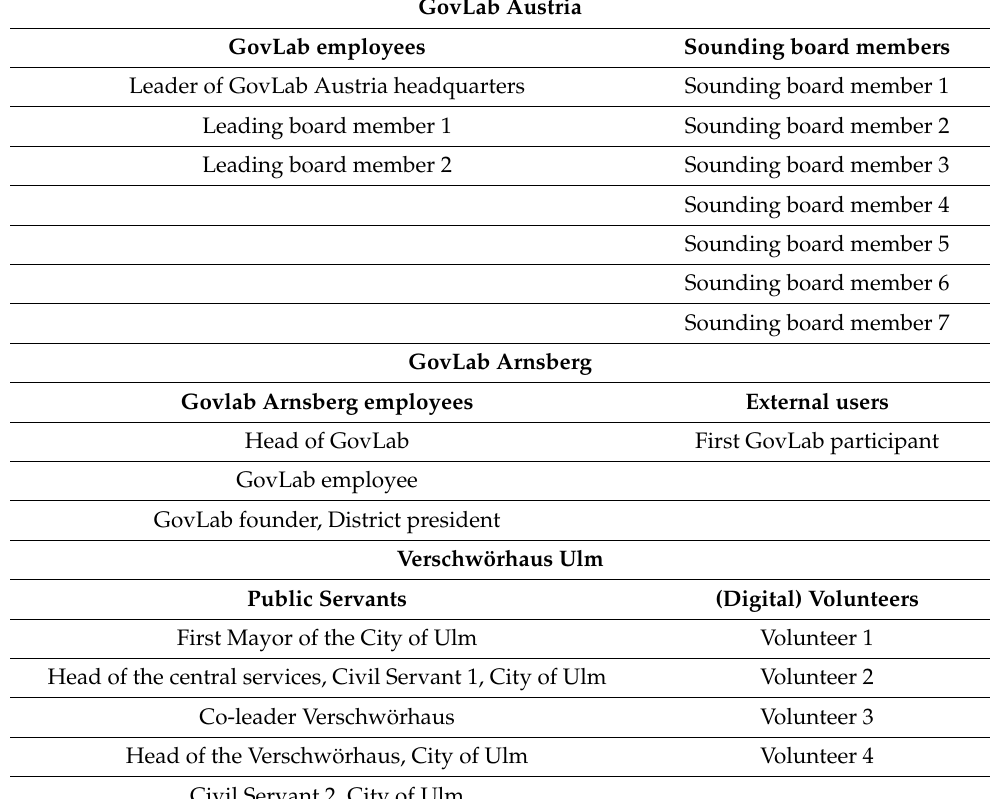
Table 1. Overview of the interviews